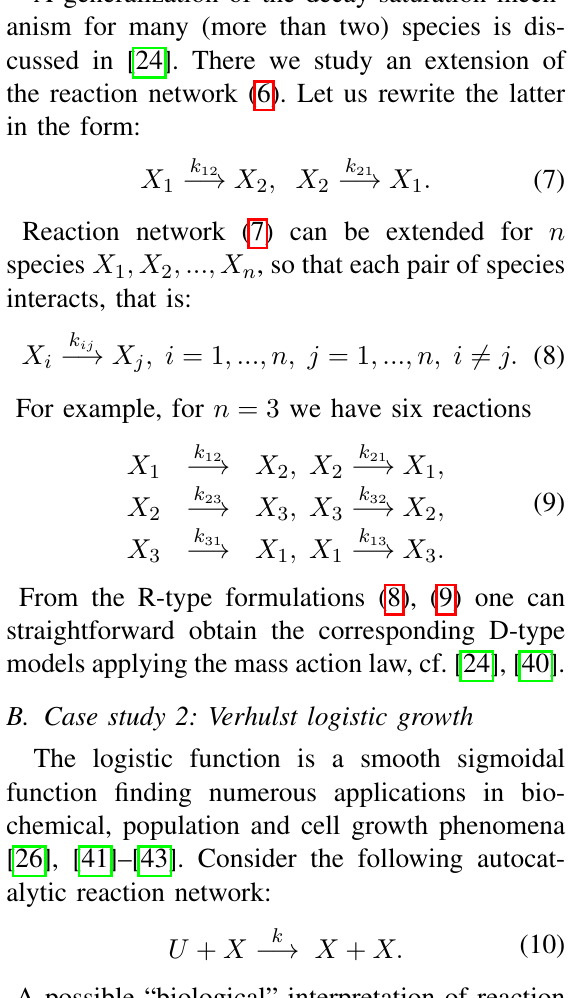
Fig. 1. Solutions to the saturation-decay model (6) the initial conditions x (0) = x 0 , y (0) = y 0 . The solutions x, y are graphically visualized on Fig. 1 for x 0 = 1 . 0 , y 0 = 0 . 0 . Assuming k ≥ k x decays and y is − 1 means that